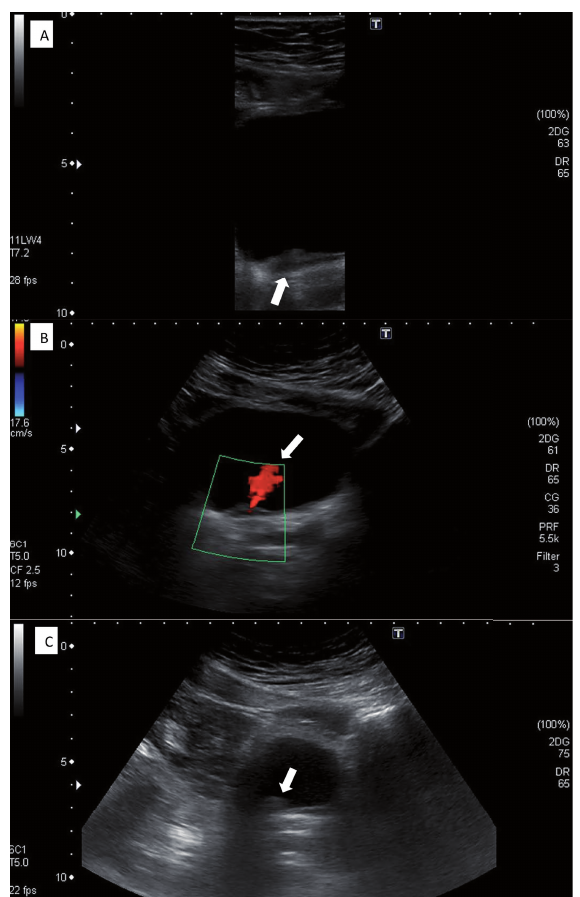
Figure 1 – A: US with an area of focal thickening in the bladder fl oor (arrow); B: The focal thickening in the bladder fl oor is close to the ureteral meatus (arrow show the ureteric jet in US doppler); C: Nodular lesion in the bladder fl oor, close to the focal thickening